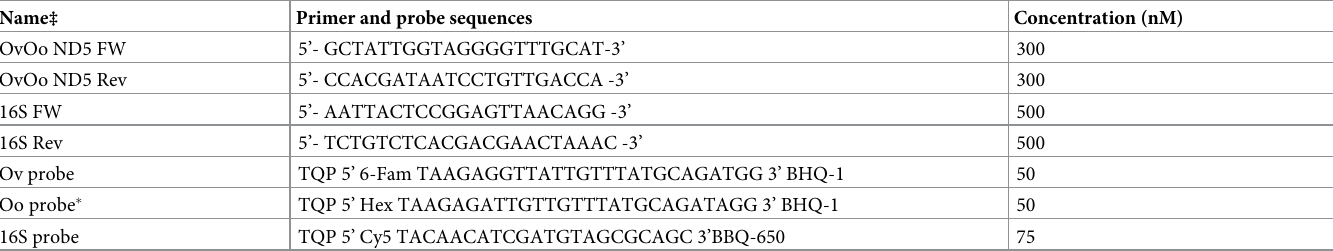
Table 2. Primer and hybridization probe sequences used in the triplex